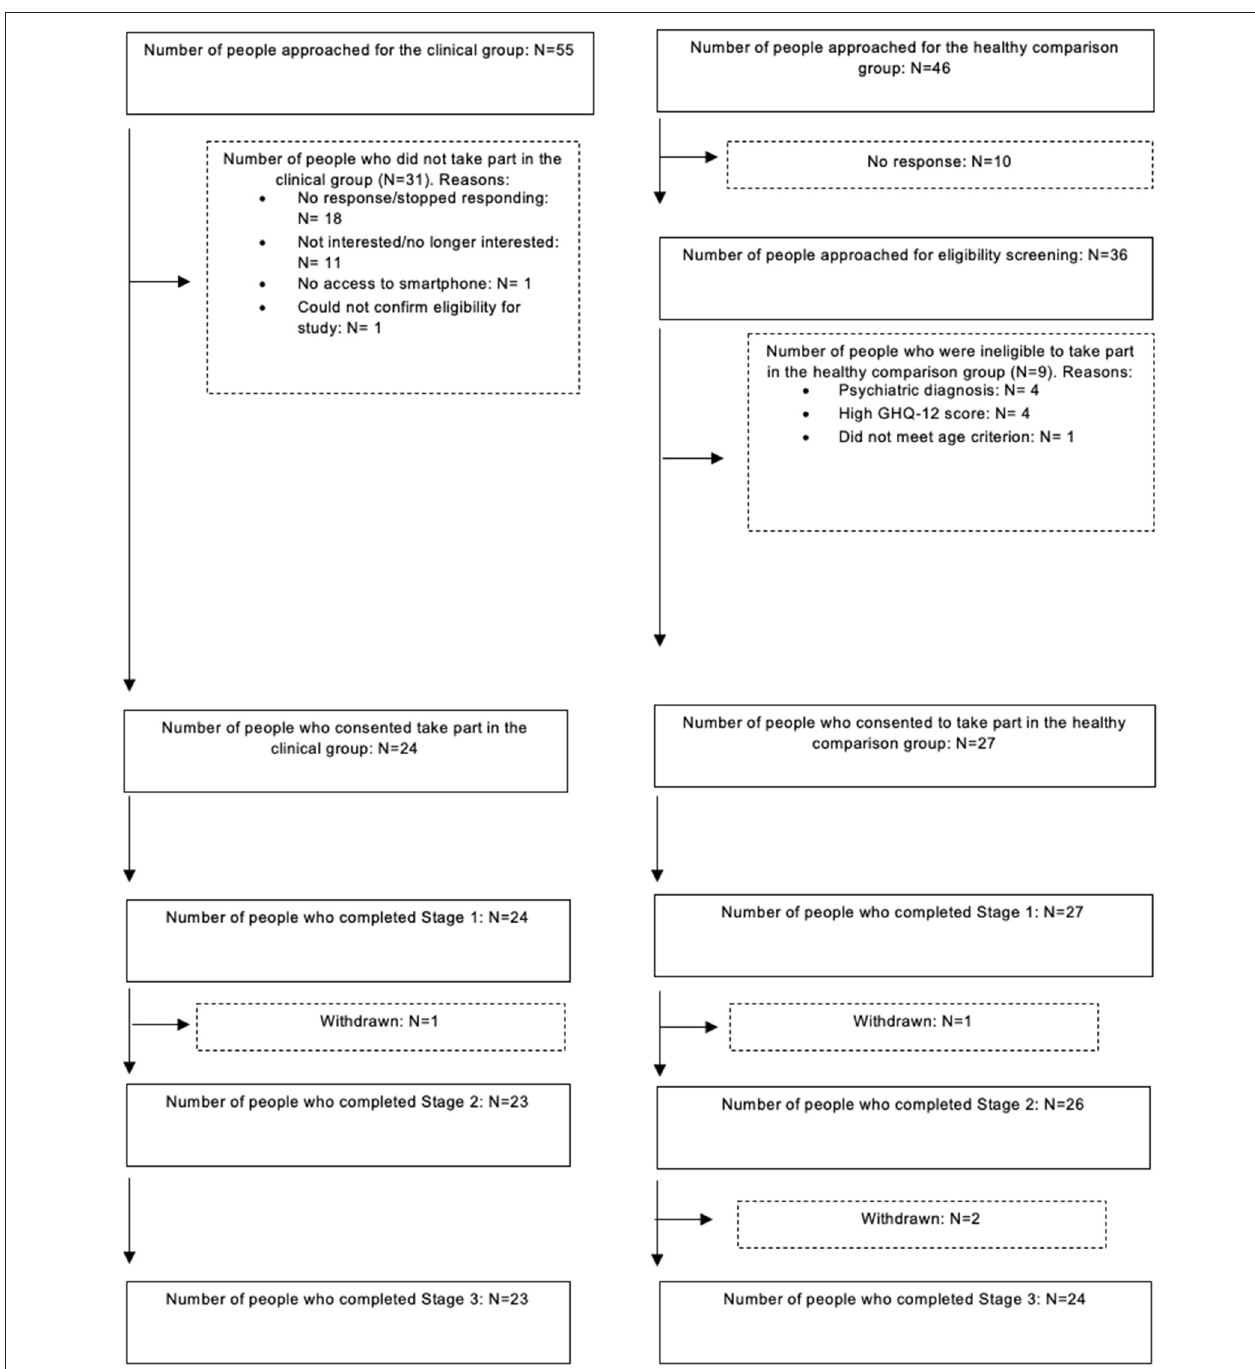
FIGURE 2 | Overview of study recruitment process.